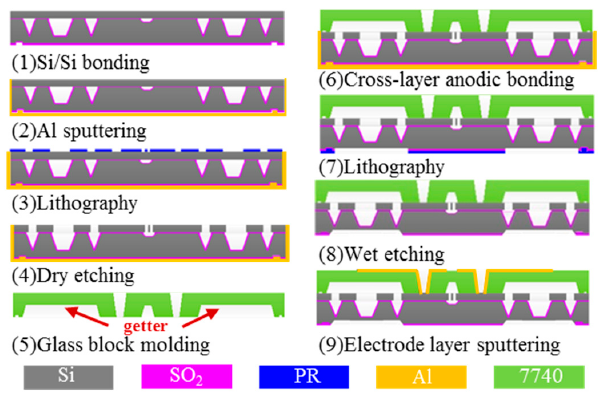
Figure 2. Schematic of the proposed tri-layer wafer level package with cross-layer anodic bonding and getter integrated.